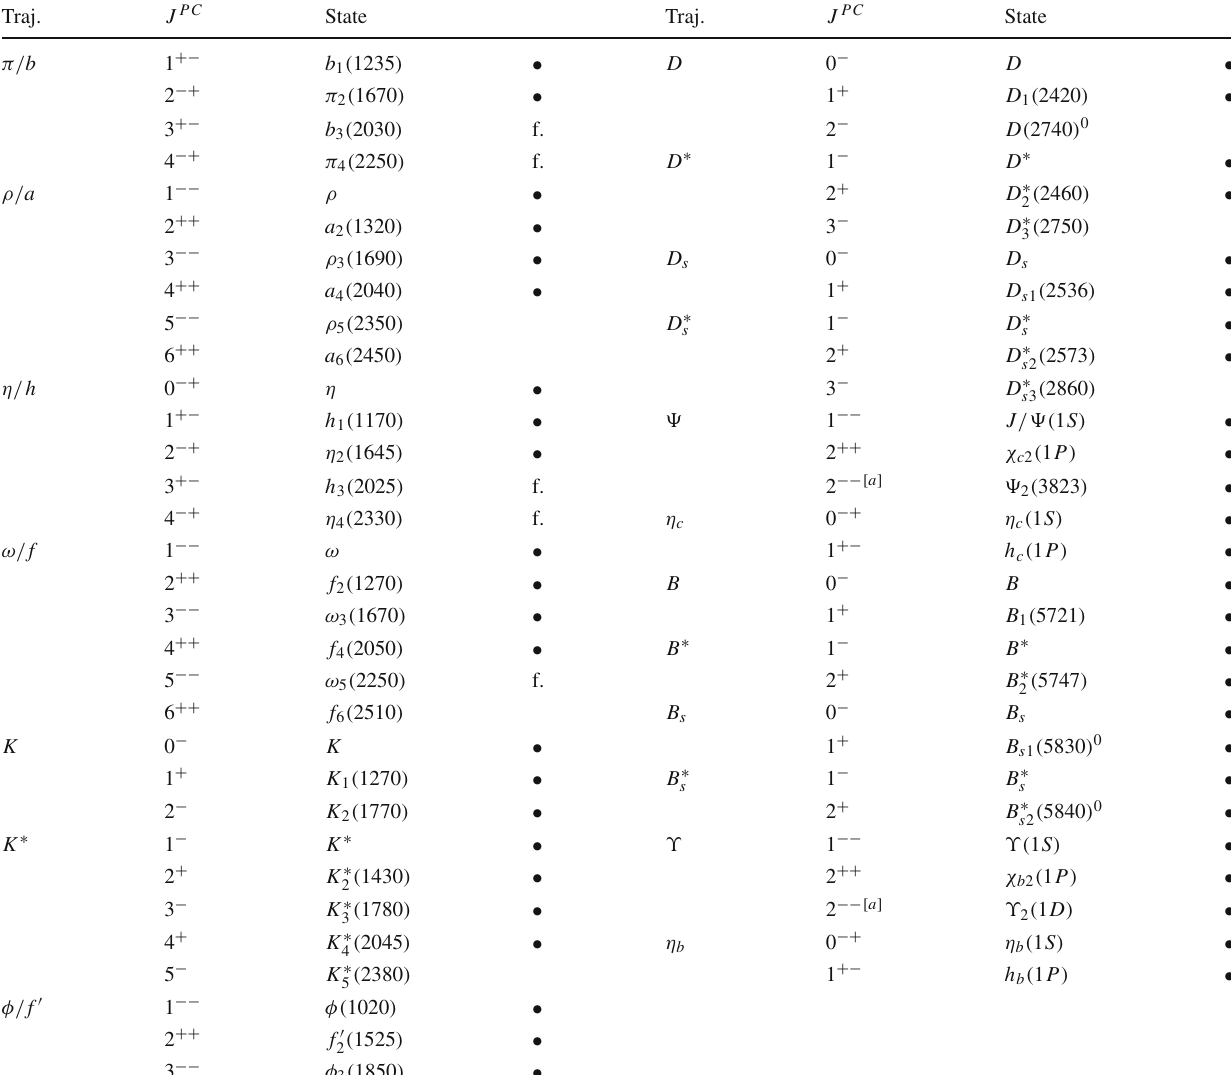
Table 14 All the meson states on the orbital leading Regge trajecto- ries used in our fits. With the sole exception of the b ¯ b , all belong on trajectories with the same slope, α (cid:2) = 0 . 88 GeV − 2 . The fourth column indicates the status given to each state by the PDG. States marked with a bullet are well established, while those marked with an “f.” are listed as Traj.